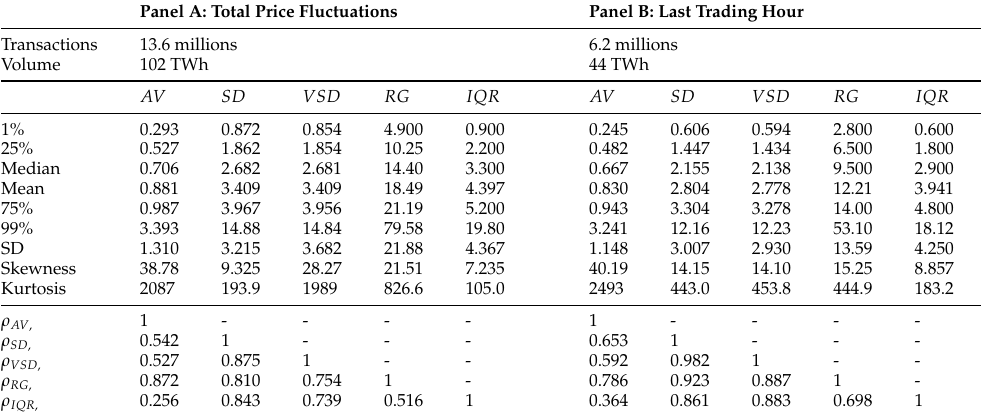
Table 1. Descriptive statistics and correlations between the five fluctuation measures. Panel A covers all data and Panel B only the final trading hour of each contract. AV is the standard deviation of the price differences of consecutive trades. SD is the standard deviation, VSD the volume-weighted average standard deviation, RG the range, and IQR the interquartile range of all prices for a single contract. All figures of the descriptive statistics for the measures are given in EUR per MWh.